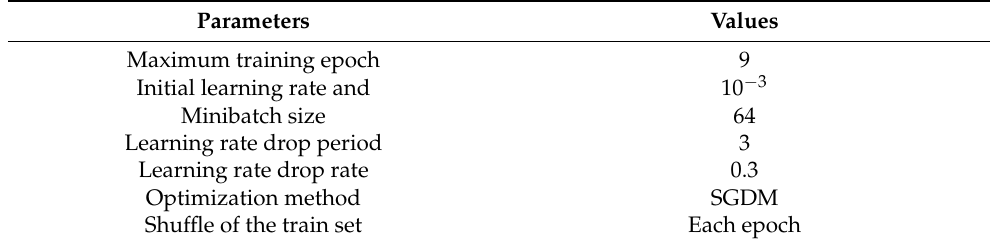
Table 3. Configurations of hyper-parameters.